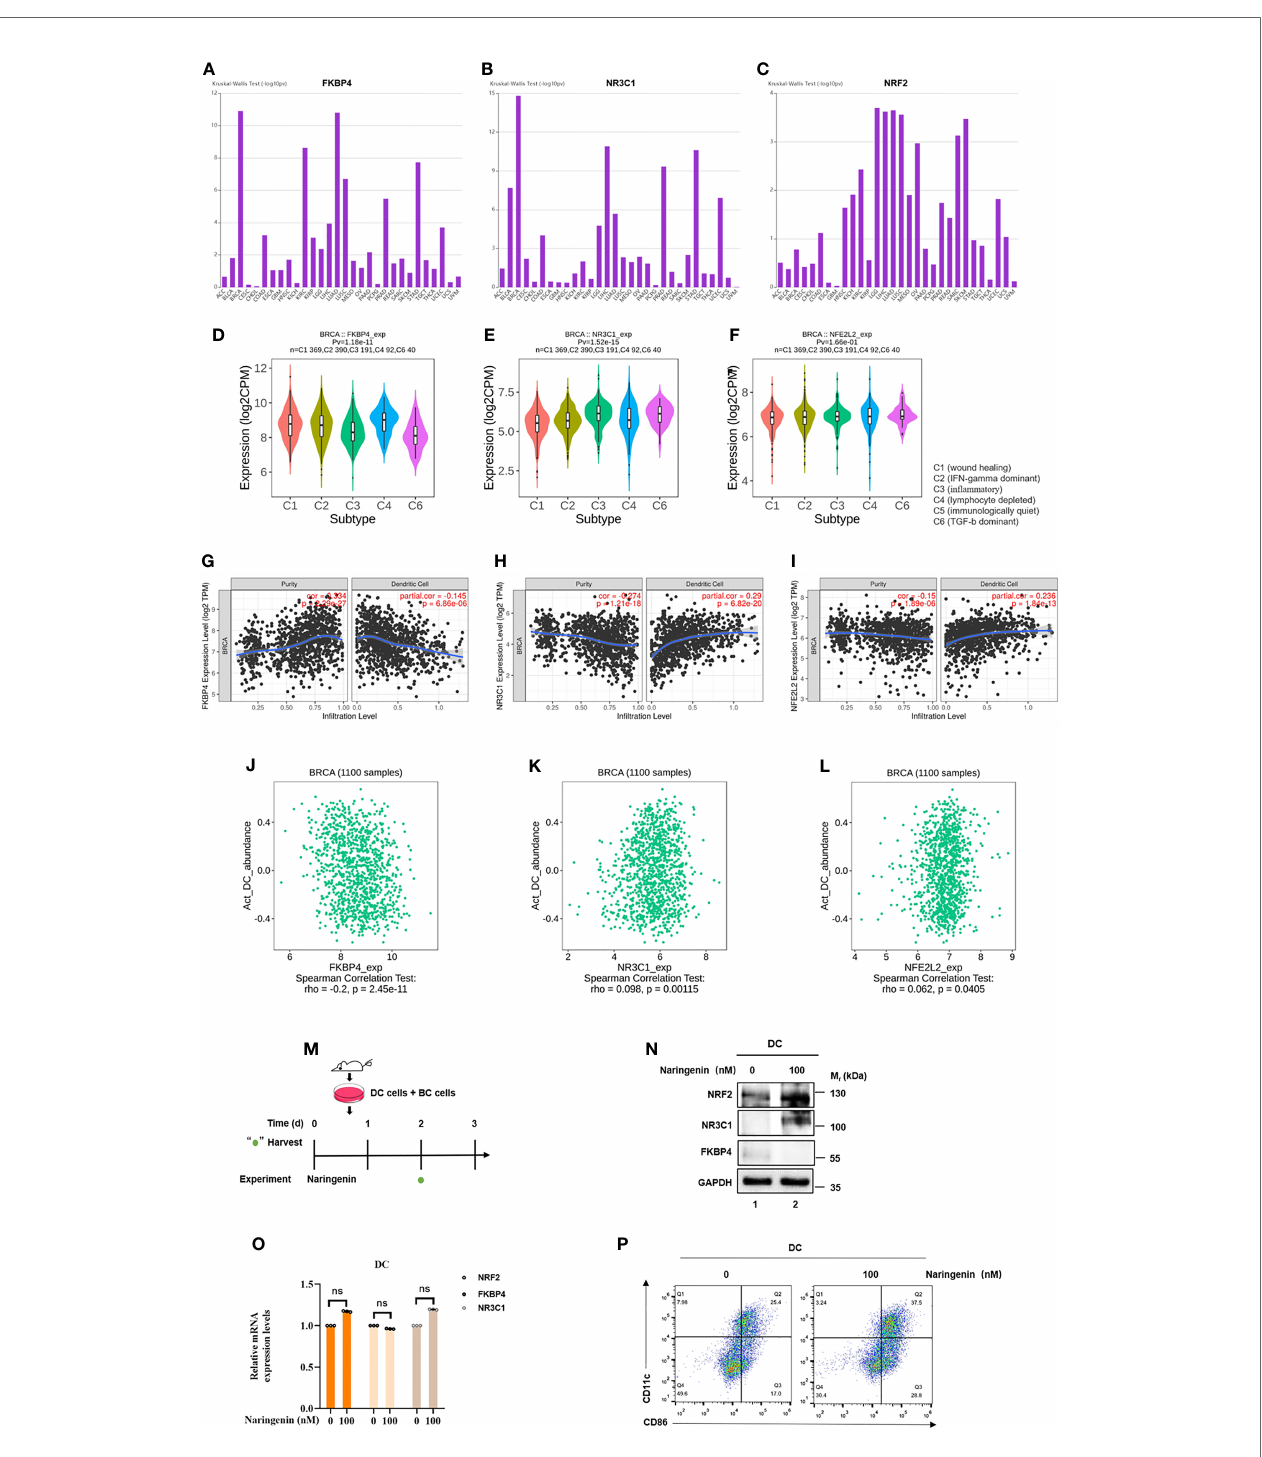
FIGURE 6 | FKBP4/NR3C1/NRF2 signaling pathway involved in naringenin-induced DC differentiation and maturation. (A – C) Distribution of FKBP4, NR3C1, and NRF2 expression across immune subtypes in pan-cancer analysis using TISIDB database. (D – F) Distribution of FKBP4, NR3C1, and NRF2 expression across immune subtypes only in breast cancer using TISIDB database. (G – I) Spearman correlations between expression of FKBP4, NR3C1 or NRF2 and in fi ltration level of DCs in breast cancer using TIMER database. (J – L) Spearman correlations between expression of FKBP4, NR3C1 or NRF2 and abundance of DCs in breast cancer using TISIDB database. (M) Schema of mice DC cells co-cultured with BC cells treated by naringenin. (N) Western blot analysis of NR3C1, FKBP4, and NRF2 protein expression in DCs co-cultured with BC cells for 3 days. (O) RT-qPCR analysis of NR3C1, FKBP4, and NRF2 mRNA expression in DCs co-cultured with BC cells for 3 days. (P) DC cells were treated with naringenin for 72 h and analyzed for maturation by fl ow cytometry analysis. ns,